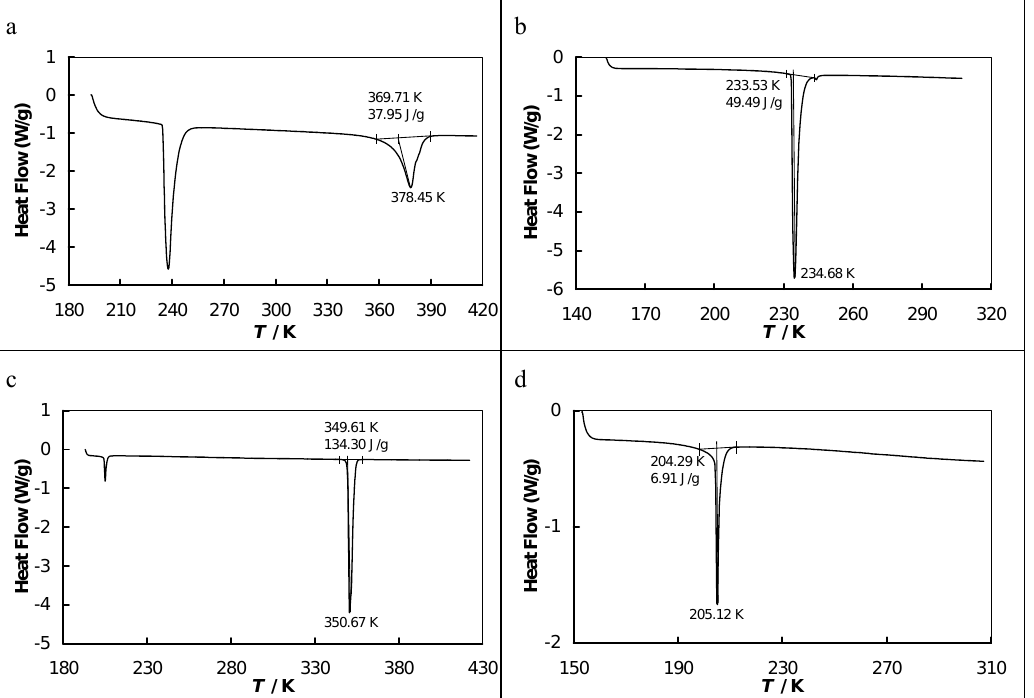
Figure 1. The DSC diagrams for: (a) [EMPYR][CF (b) [EMPYR][CF range of temperatures; [PMPYR][CF